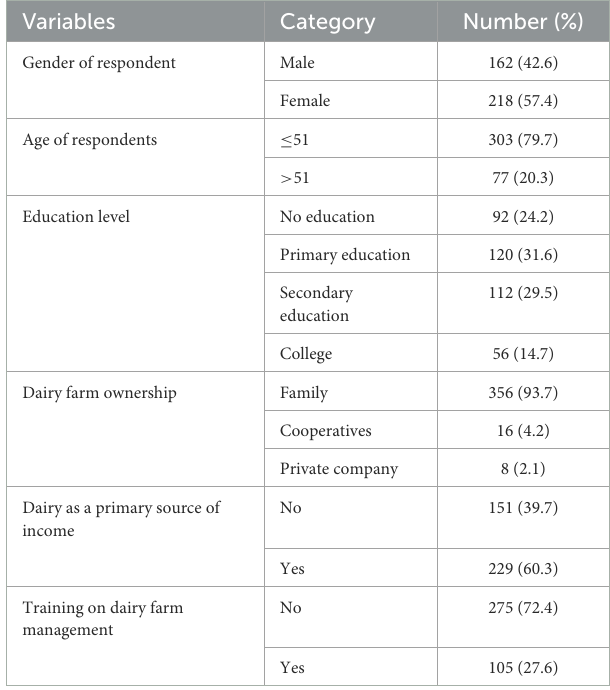
TABLE 3 The demographic characteristics of dairy respondents in central Ethiopia ( n =